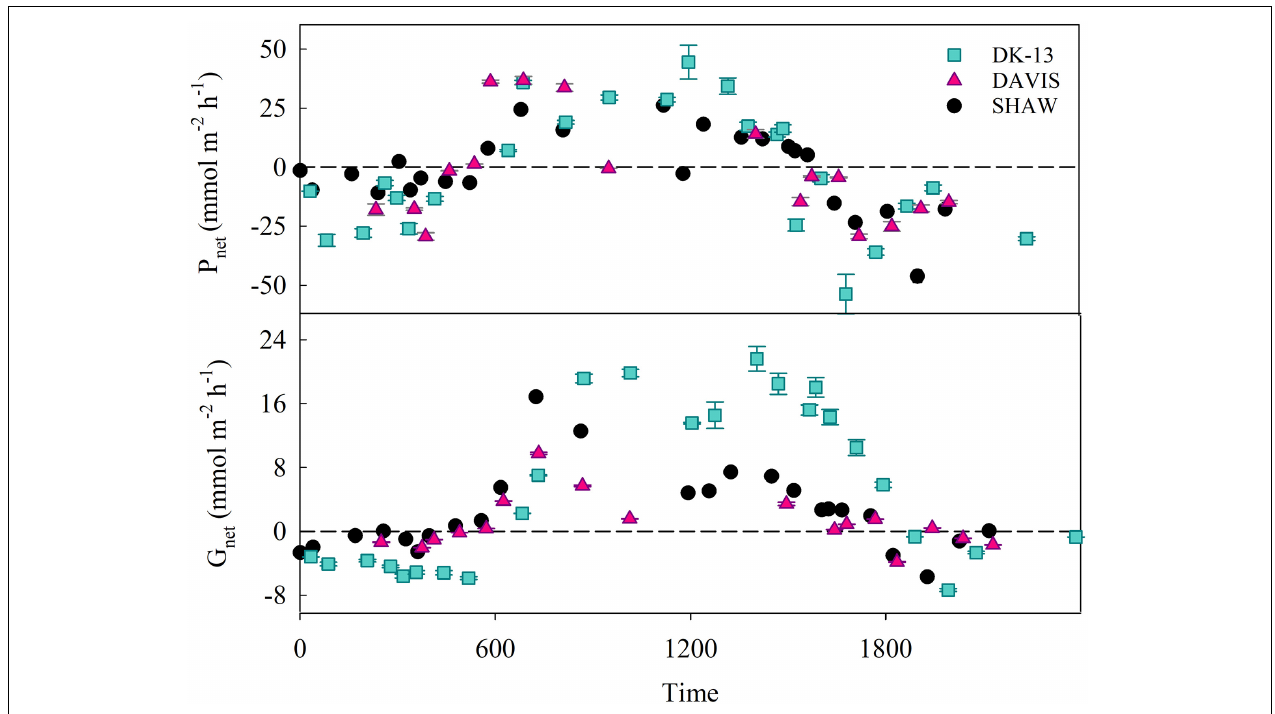
FIGURE 3 | Calculated values of P net and G net ( ± SE) for each sampling period at all study sites. Error bars are not visible in many cases as the error is smaller than the symbol. Dotted lines represent net 0 production for G net and P net .